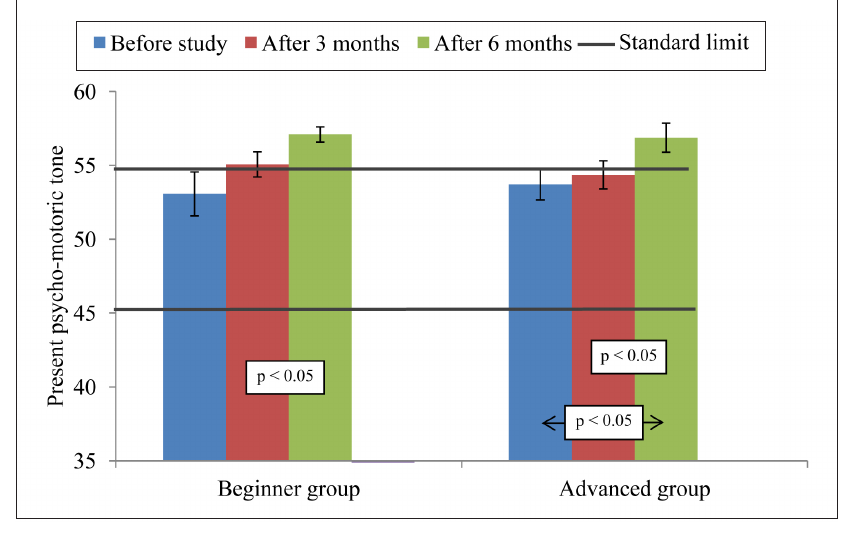
Figure 3. Present extra-introversity in the beginner and advanced yoga